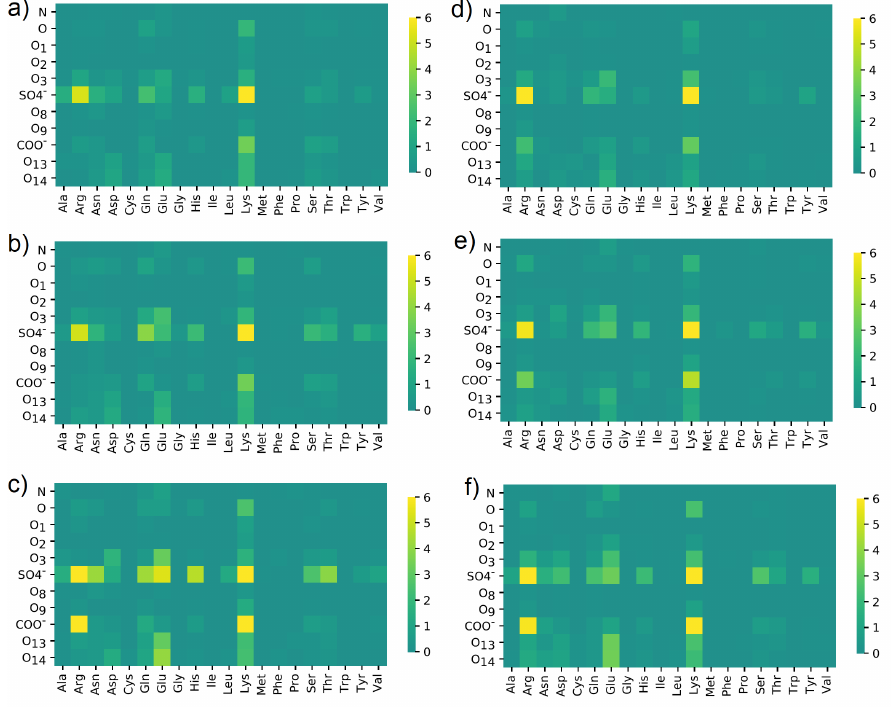
Figure 10. HBo distribution between different oxygen classes in ( a – c ) CS-6 and ( d – f ) CS-4; and different amino acids in HSA. Data were obtained in solutions containing: ( a , d ) NaCl; ( b , e ) CaCl 2 ; ( c , f ) MgCl 2 . The maps present a number of interactions. The denotation of the atoms and functional groups is presented in Figure